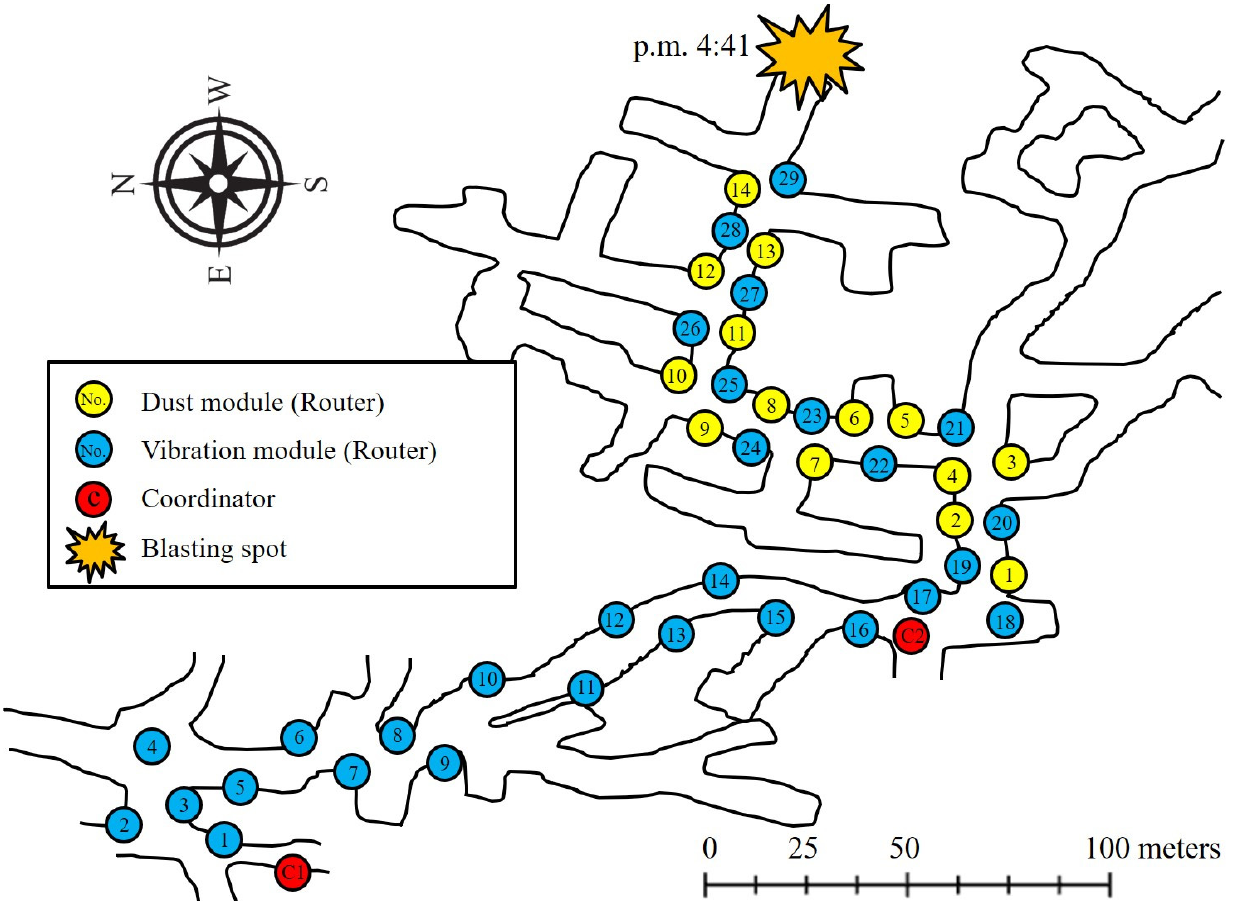
Figure 5. Drift map of Samdo Mine showing installed modules and blasting spot.